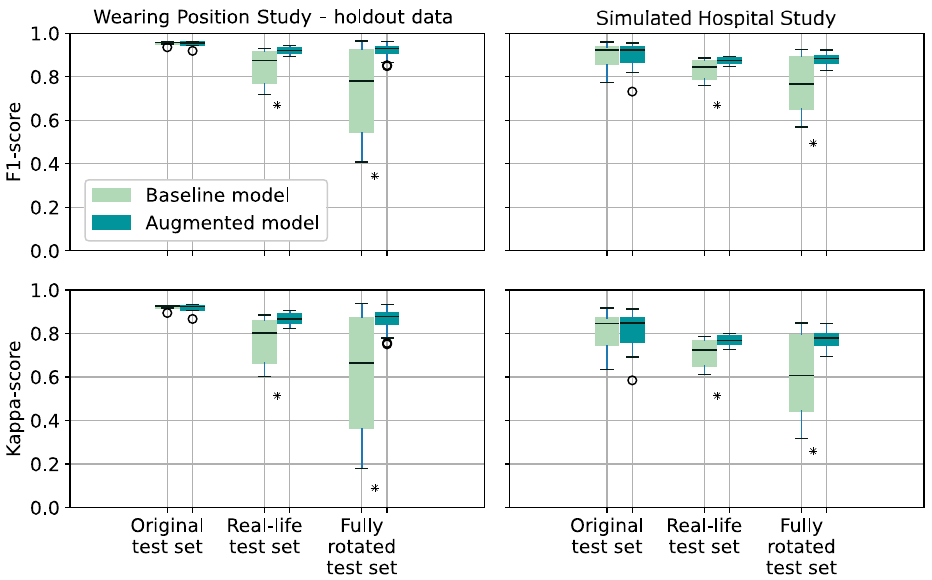
Figure 7. F1-score (top panels) and Kappa-score (bottom panels) of the baseline and the augmented model for the three test sets: Original, real-life and fully rotated test sets. *: test sets obtained statistically different results for the baseline and augmented model with a p -value <